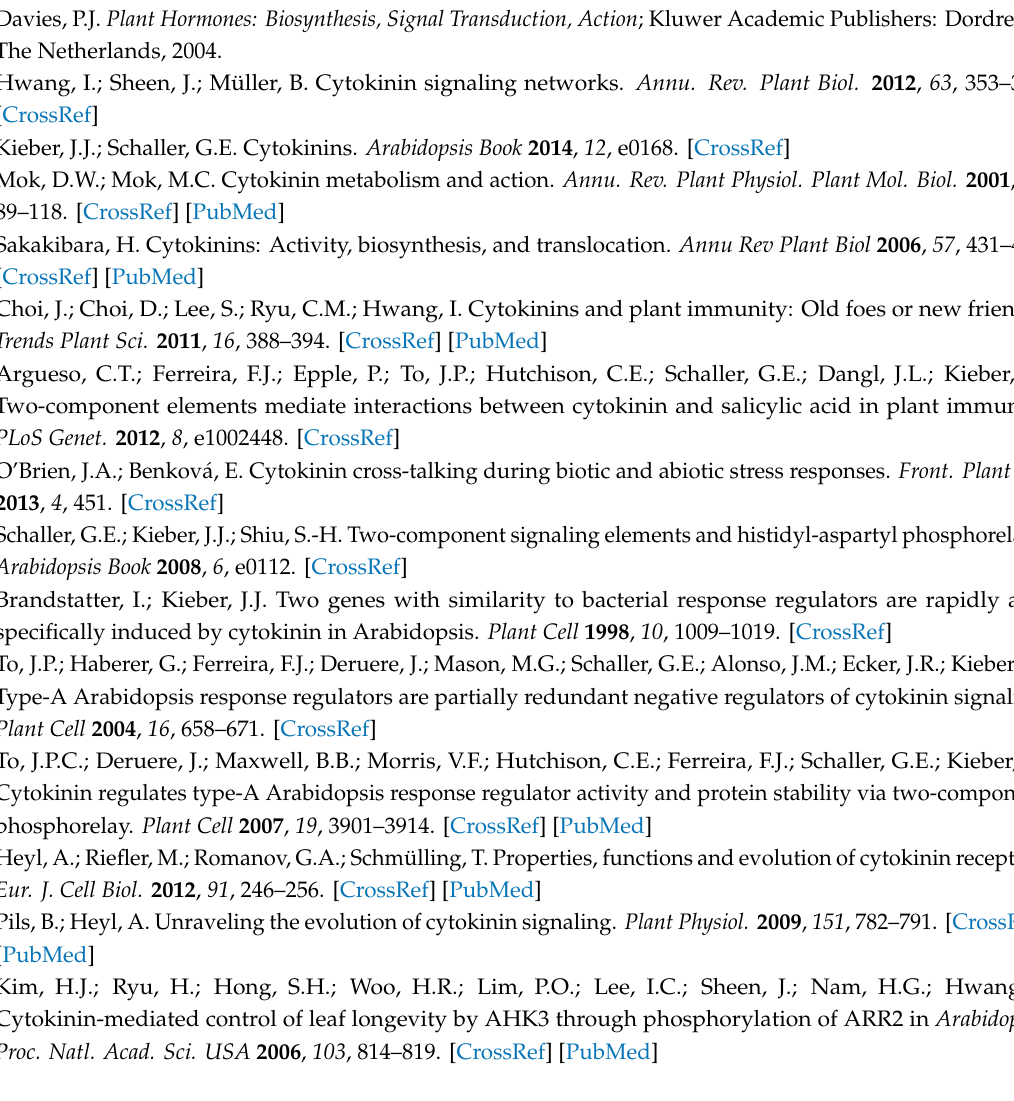
Table S1: Conserved type-B ARR candidate genes. Table S2: Golden type-B ARR targets. Table S3: Hormone crosstalk